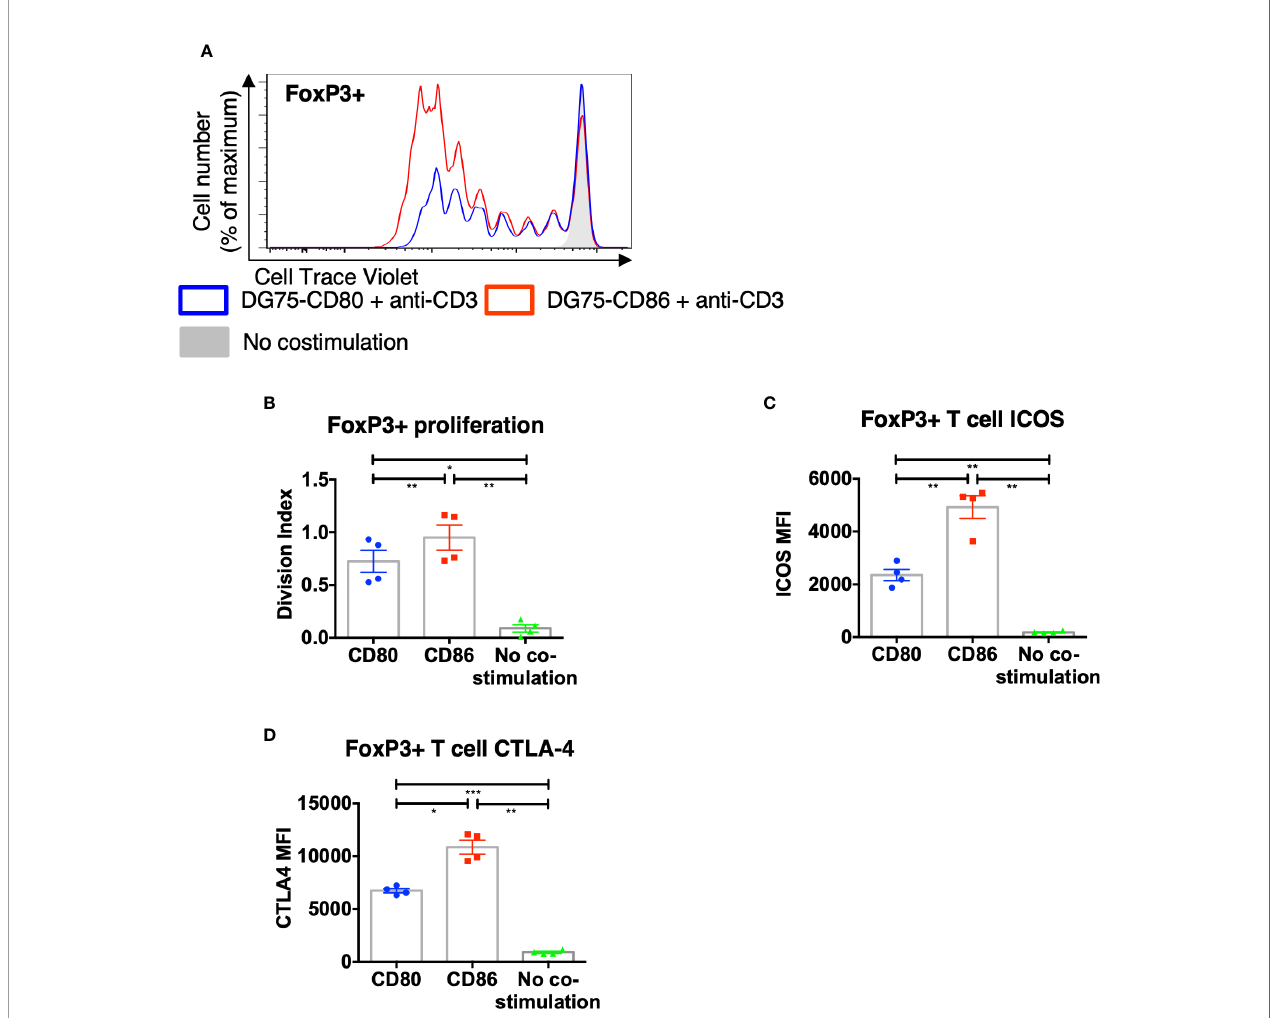
FIGURE 4 | CD86-CD28 costimulation from human model APCs enhances T cell proliferation and expression of CTLA-4 and ICOS. CTV labelled total memory CD4 T cells isolated from healthy donors were cultured for 5 days with DG75-CD80, DG75-CD86, or untransduced DG75 (no costimulation), at a ratio of 1:1 T cells to DG75, with 0.5 m g/ml anti-human-CD3. After 5 days proliferation was assessed by CTV dilution. (A) representative proliferation traces of FoxP3+ cells following costimulation with CD86 or CD80. (B) FoxP3+ T cell division indices, (C) ICOS and (D) CTLA4 expression following costimulation with CD80 or CD86. Data from four independent experiments. One-way ANOVA with Tukey ’ s multiple comparisons tests: *p ≤ 0.05, **p ≤ 0.01, ***p ≤